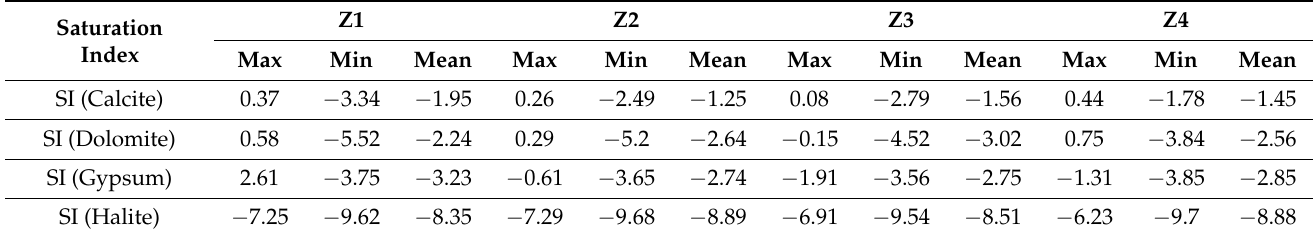
Table 4. Saturation index of groundwater samples in four zones.